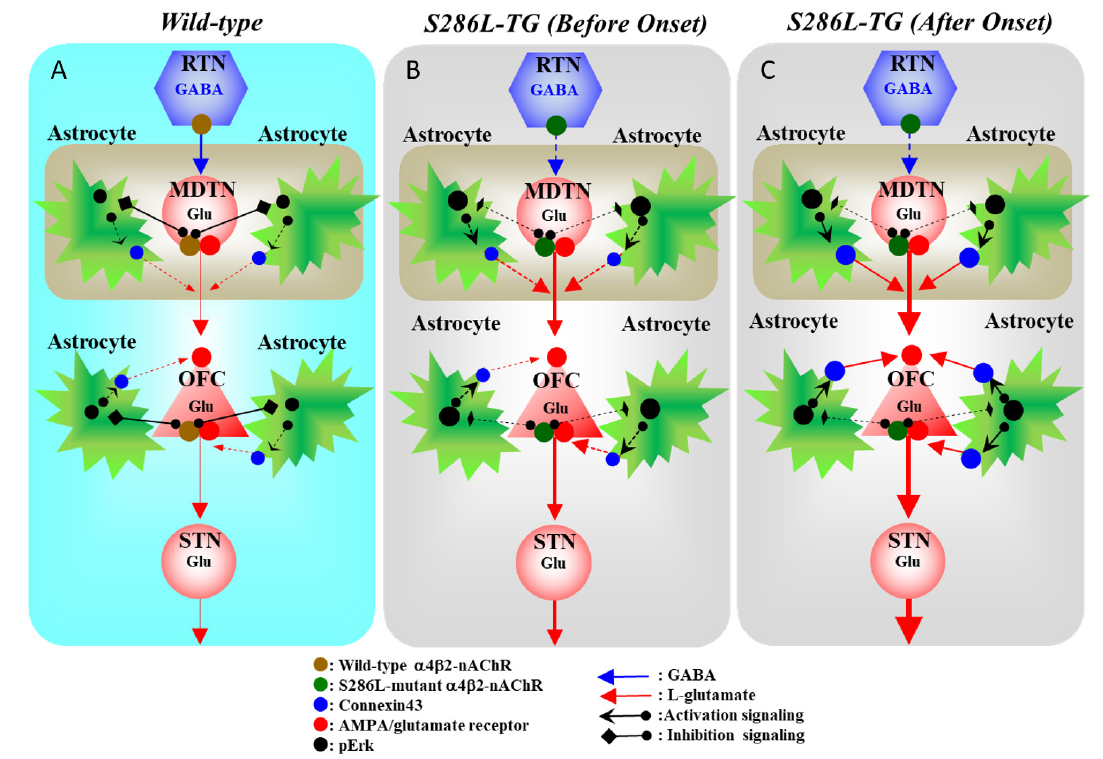
Figure 8. Proposed hypothesis of the multi-stage pathomechanisms of S286L-TG. Proposed hypothesis for the functional abnormalities of glutamatergic transmission in the thalamocortical and cortical hyperdirect pathways in the wild-type ( A ), S286L-TG before ADSHE onset ( B ), and after ADSHE onset ( C ). Reticular thalamic nucleus (RTN) mainly projects GABAergic terminals to various thalamic nuclei, including mediodorsal thalamic nucleus (MDTN). The activation of α 4 β 2-nAChR in the RTN enhances GABAergic transmission in the RTN–MDTN pathways of the wild-type ( A ), whereas the S286L-mutant α 4 β 2-nAChR impairs the activation of GABAergic transmission in the RTN–MDTN in S286L-TG ( B , C ). MDTN project glutamatergic terminals to the OFC. In the MDTN, both α 4 β 2-nAChR and the AMPA / glutamate receptor activate glutamatergic transmission to the OFC ( A – C ). Wild-type α 4 β 2-nAChR inhibits astroglial Erk, resulting in the suppression of connexin43 expression in the astroglial plasma membrane ( A ). Contrary to the wild-type, in S286L-TG, the loss-of-function S286L-mutant α 4 β 2-nAChR lacks suppressive e ff ects on pErk ( B , C ) but is insu ffi cient to upregulate connexin43 ( B ). A combination of the persistent / repetitive propagation of the hyperactivation of glutamatergic transmission in MDTN-OFC induced by the GABAergic disinhibition of S286L-TG and pErk upregulation enhances connexin43